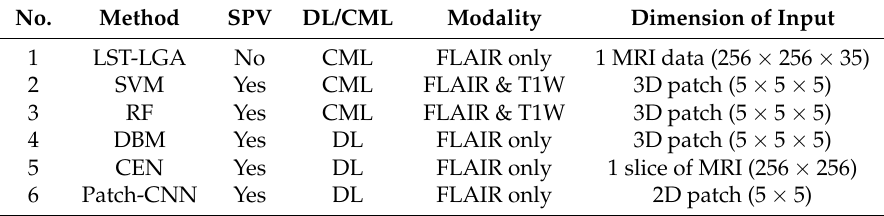
Table 2. Summary of all machine learning algorithms used in this study and their configurations: SPV, DL and CML stand for “Supervised”, “Deep Learning” and “Conventional Machine Learning”.